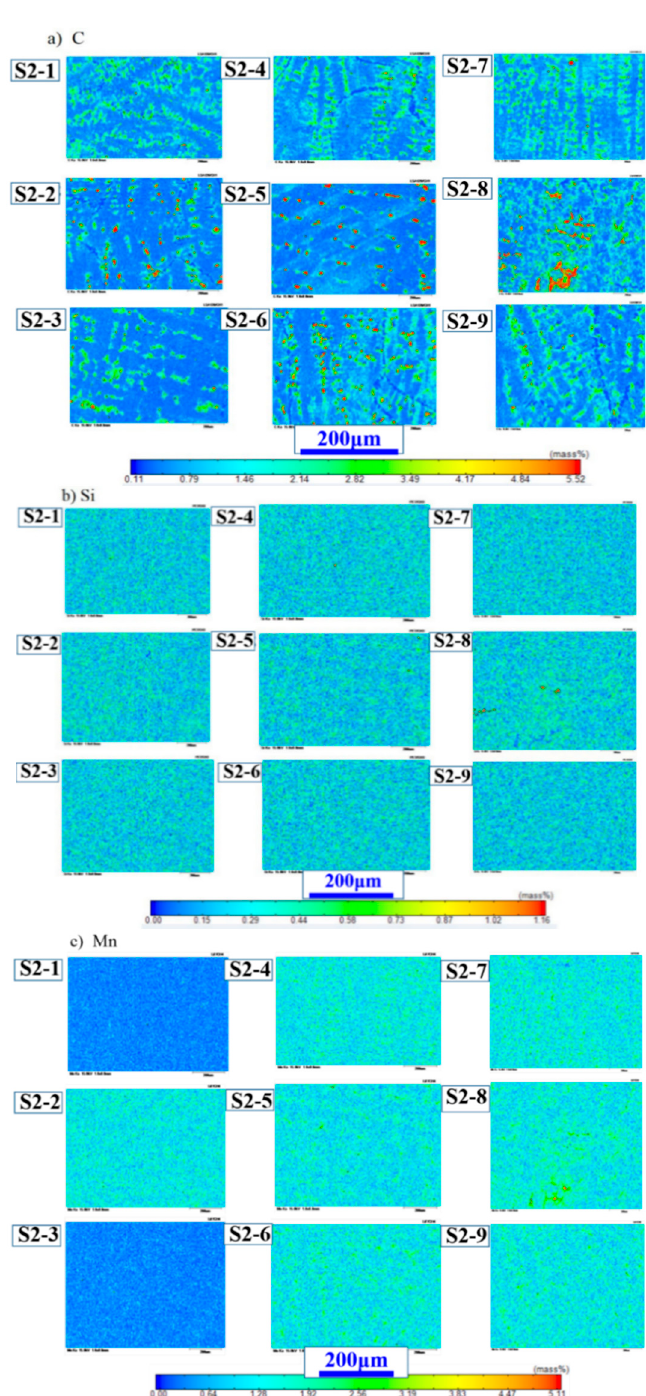
Figure 7. Results of EPMA: ( a ) C ( b ) Si ( c ) Mn.